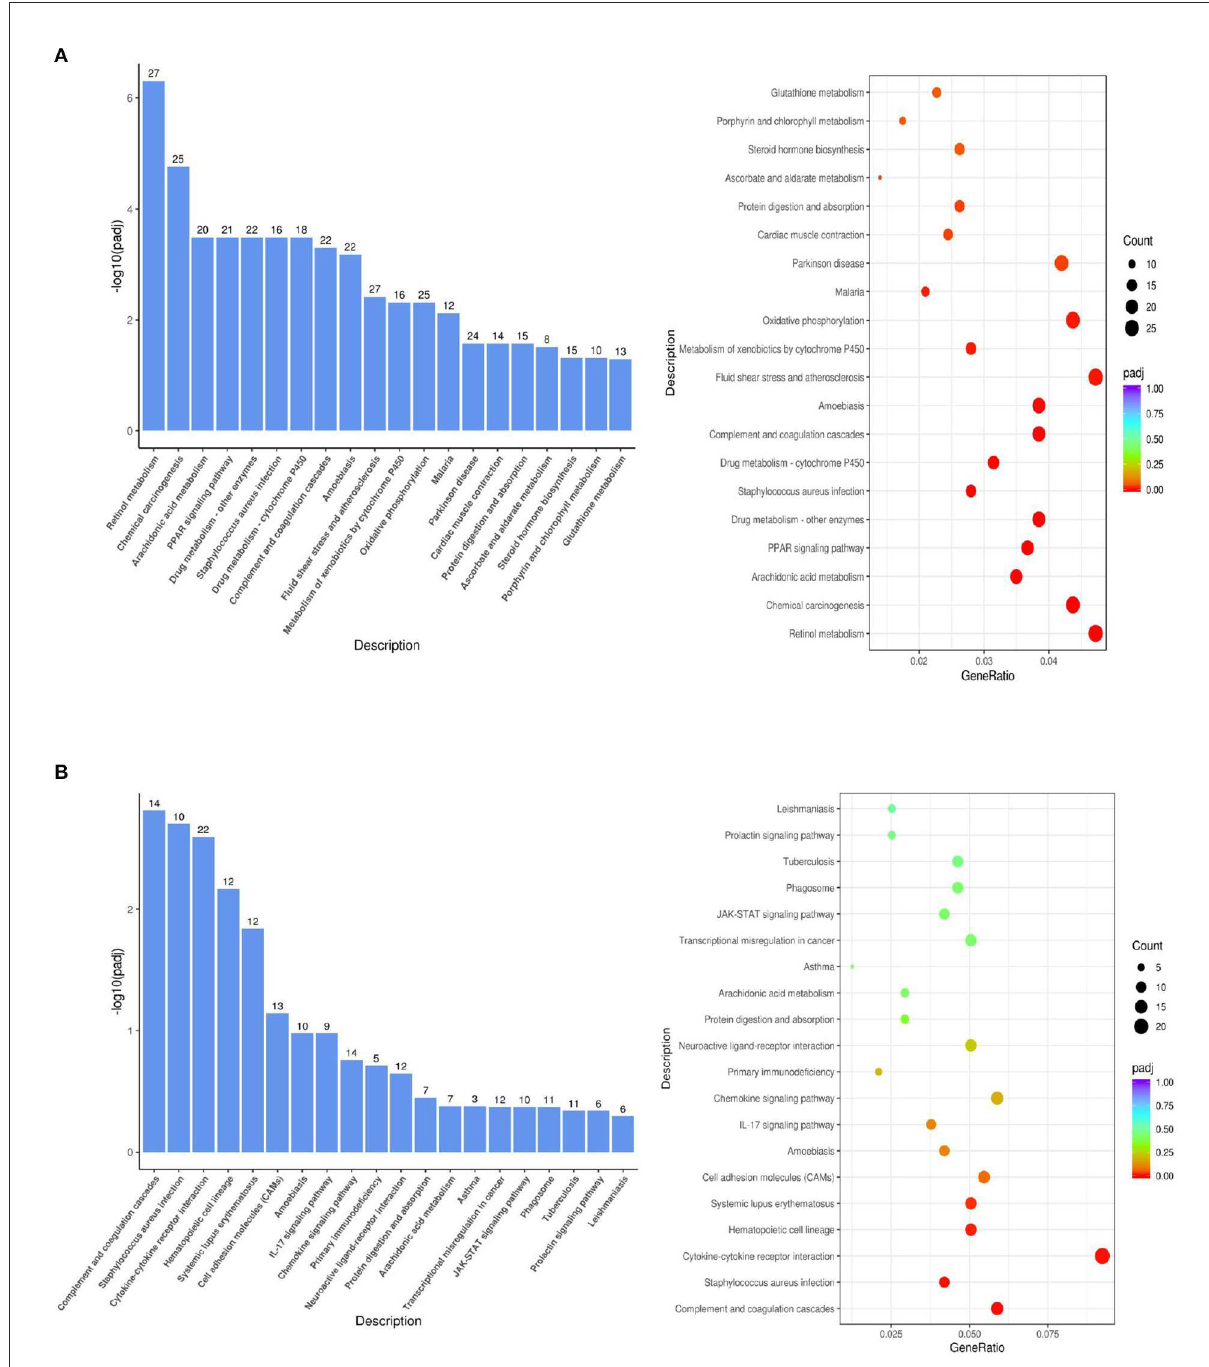
FIGURE6 KEGG pathway analysis of the difference gene expression. (A) DTE vs. Control; (B) MET vs. Control.